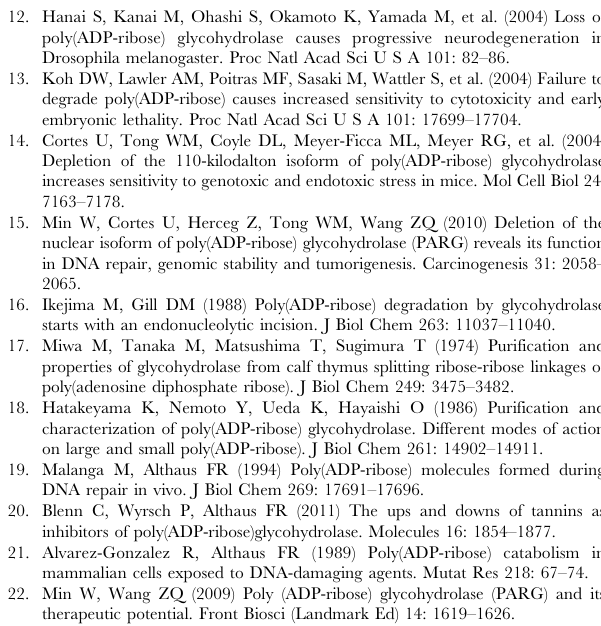
Figure S3 Coomassie Blue Stained SDS-PAGE for the purified recombinant mPARG(439–959) wild type and